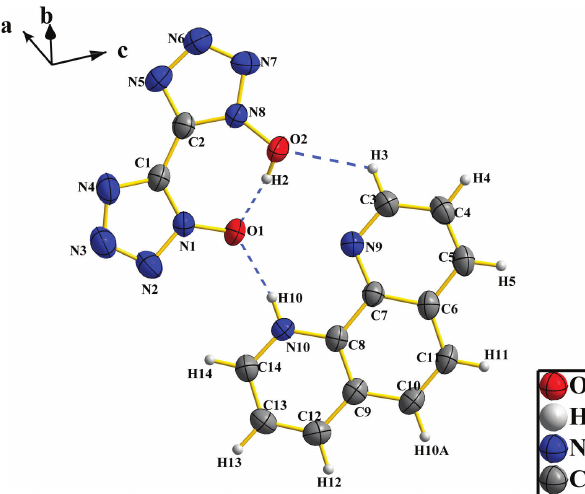
Table 2: Fractional atomic coordinates and isotropic or equivalent isotropic displacement parameters (Å 2